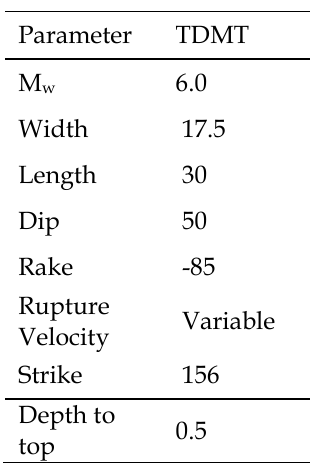
Table 1: Fault parameters and focal